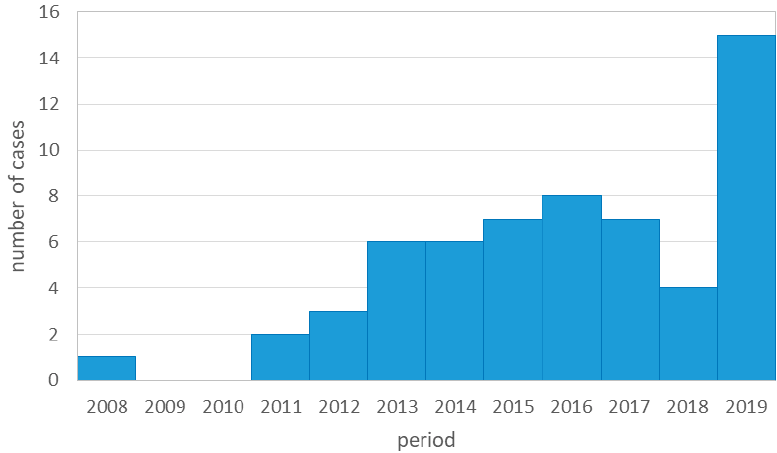
Figure 1. The number of imported cases of dengue fever reported in Romania. 50